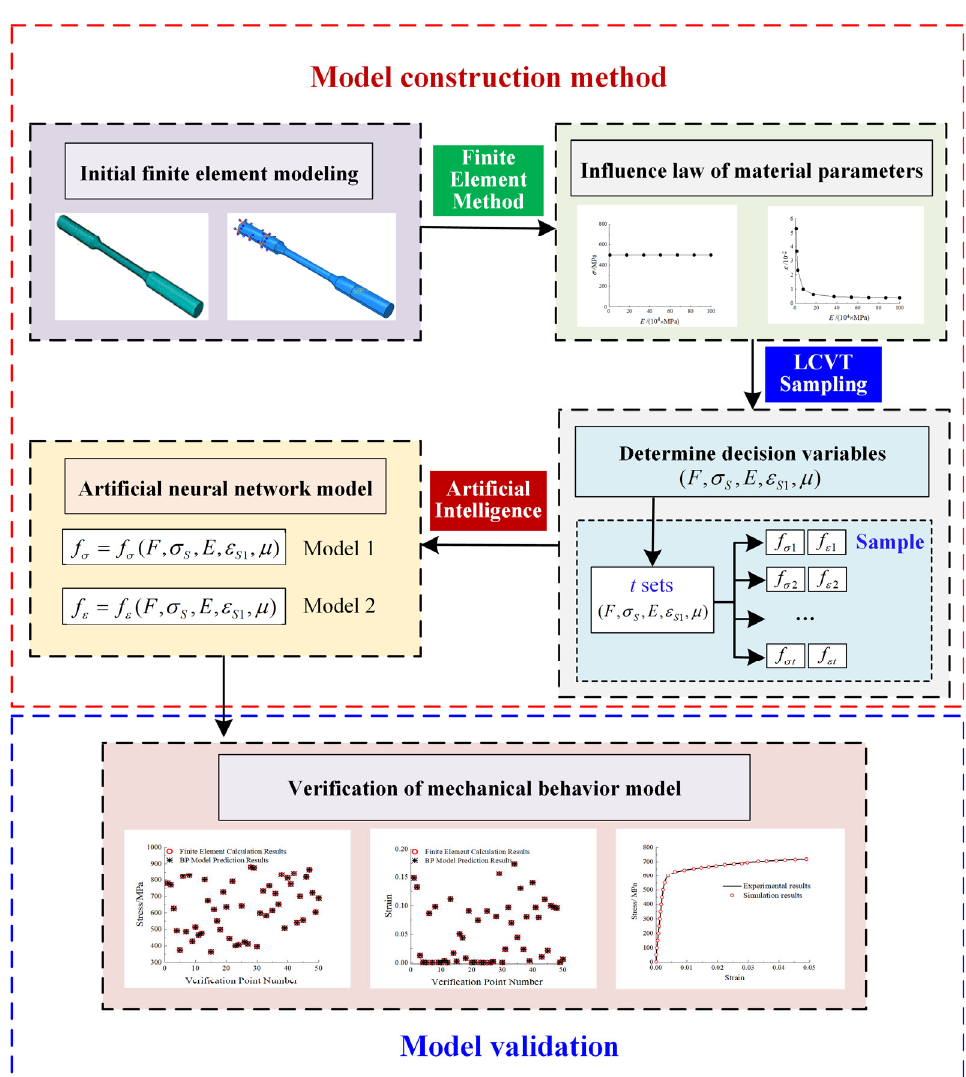
Figure 1. Model construction method.